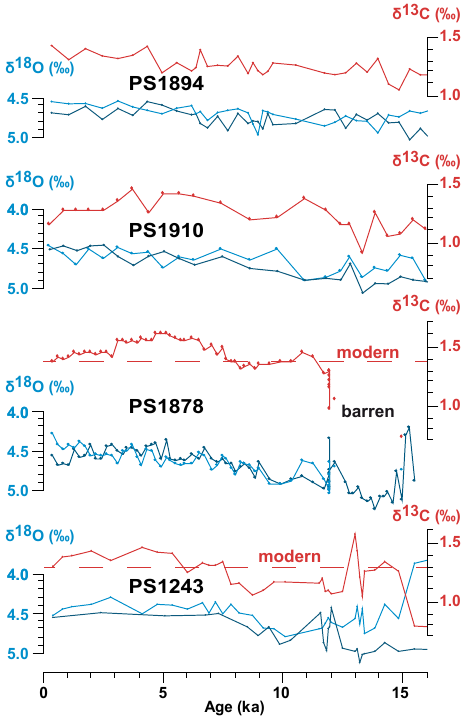
Fig. 6. Benthic oxygen (light and dark blue for C. wuellerstorfi and O. umbonatus , respectively) and carbon (red, C. wuellerstorfi ) stable isotope records (in ‰ vs. PDB) of cores PS1894, PS1910, PS1878 and PS1243 vs. age (since 16ka). Broken lines in PS1878 and PS1243 mark modern (core-top) δ 13 C values of C. wueller- storfi from the central Greenland Sea and site PS1243, respectively (Bauch and Erlenkeuser,